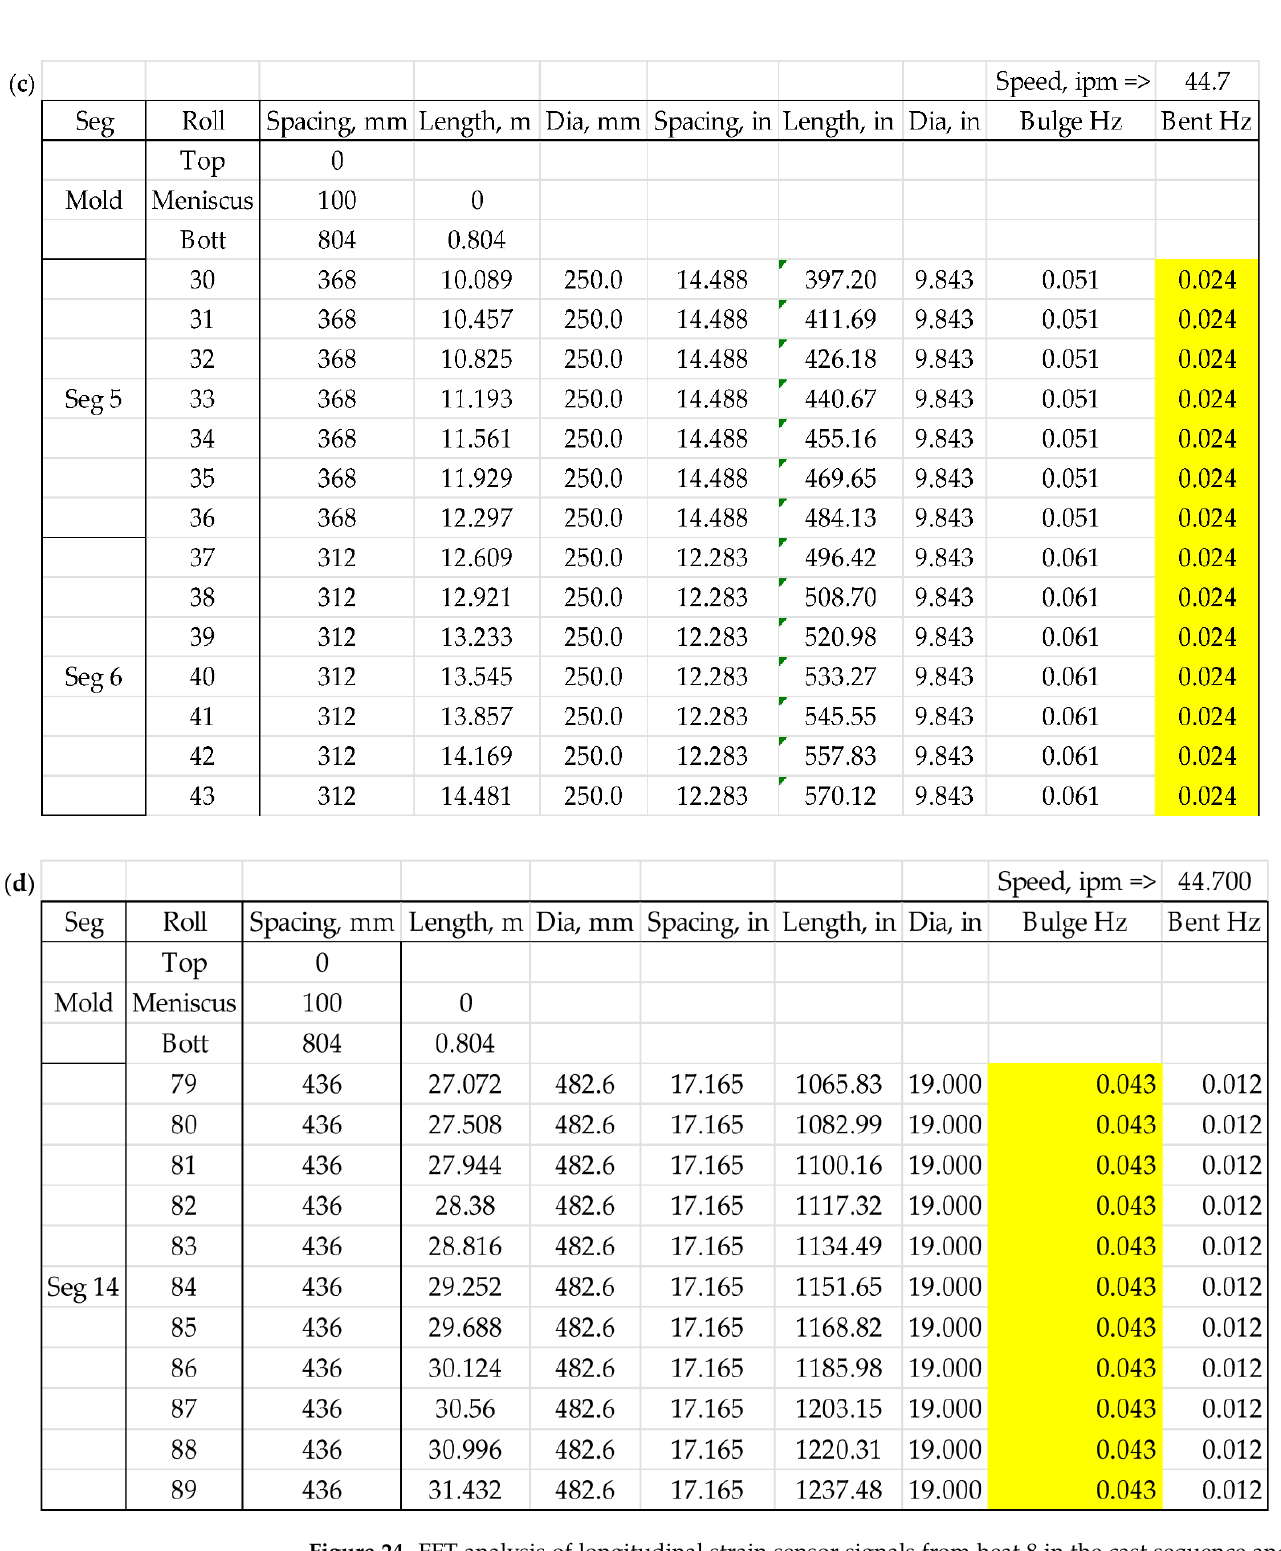
Figure 24. FFT analysis of longitudinal strain sensor signals from heat 8 in the cast sequence and highlighted locations for possible locations in the caster that might initiate the event based on matched frequency. ( a ) Chart representing roll eccentricity frequency in Segments 5 – 6. ( b ) Chart representing bulging frequency in non-segmented section 14. ( c ) Table representing eccentricity frequency for Segments 5 – 6. ( d ) Highlighted region in Table representing bulging frequency for Segment 14.